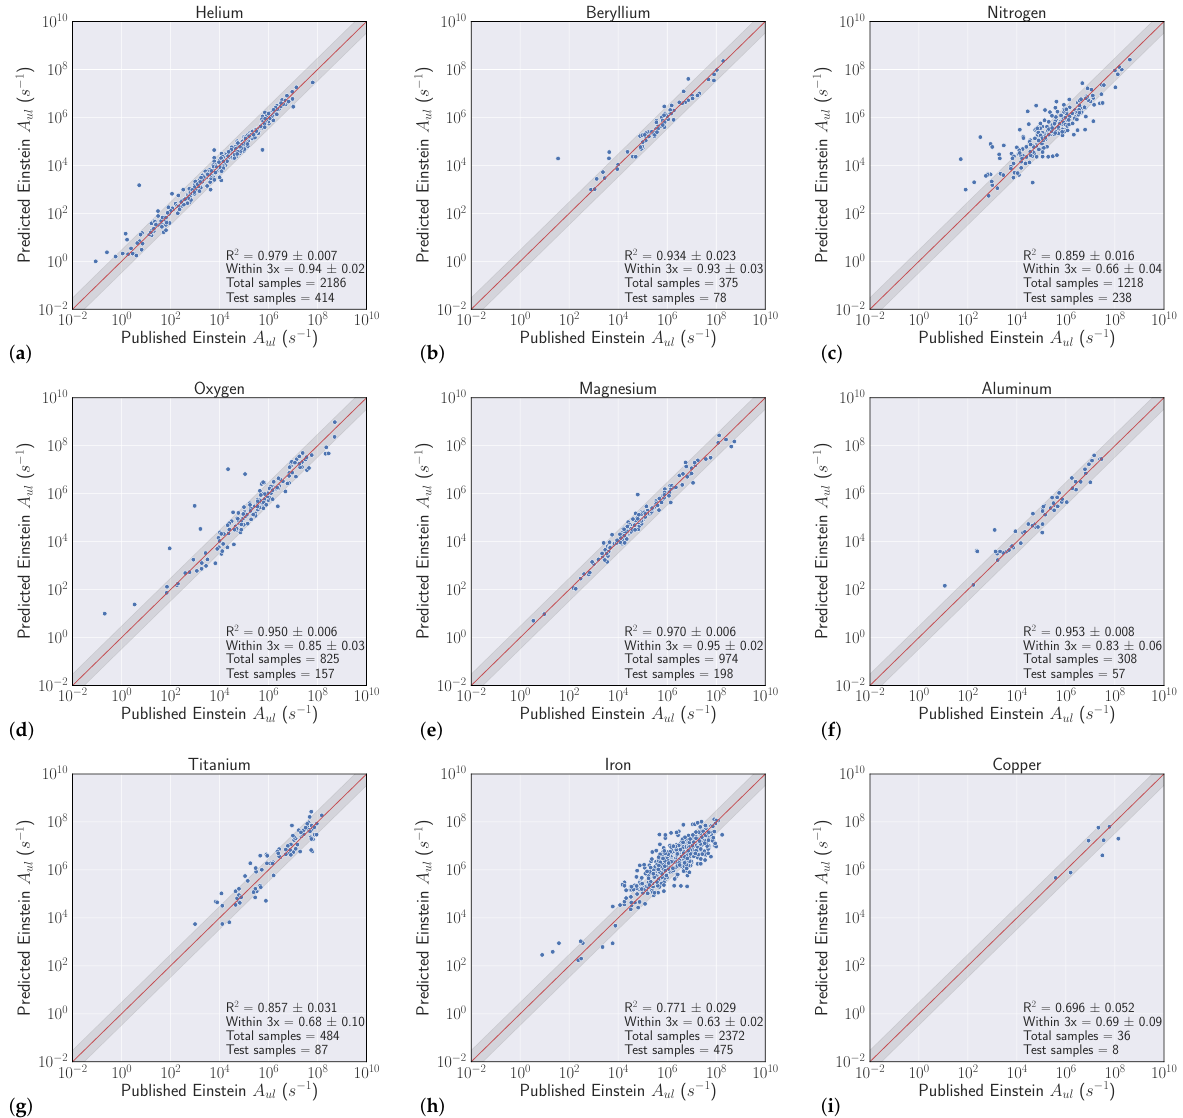
Figure 6. Predicted vs. published Einstein A-coefficients for the interelement